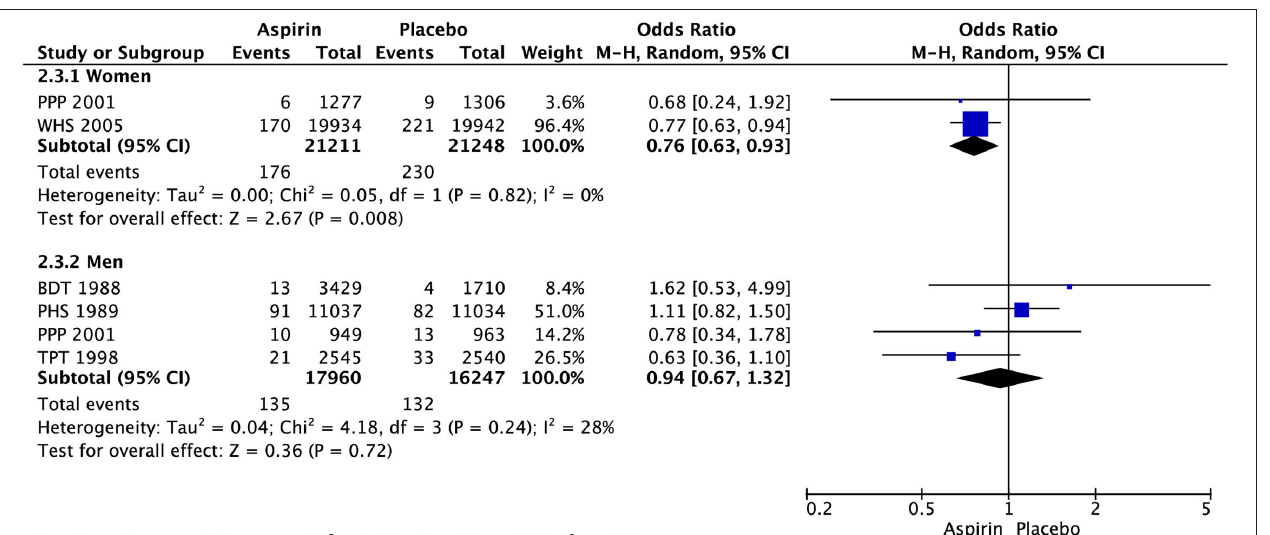
FIGURE 4 | Ischemic stroke in women and men taking aspirin or placebo.